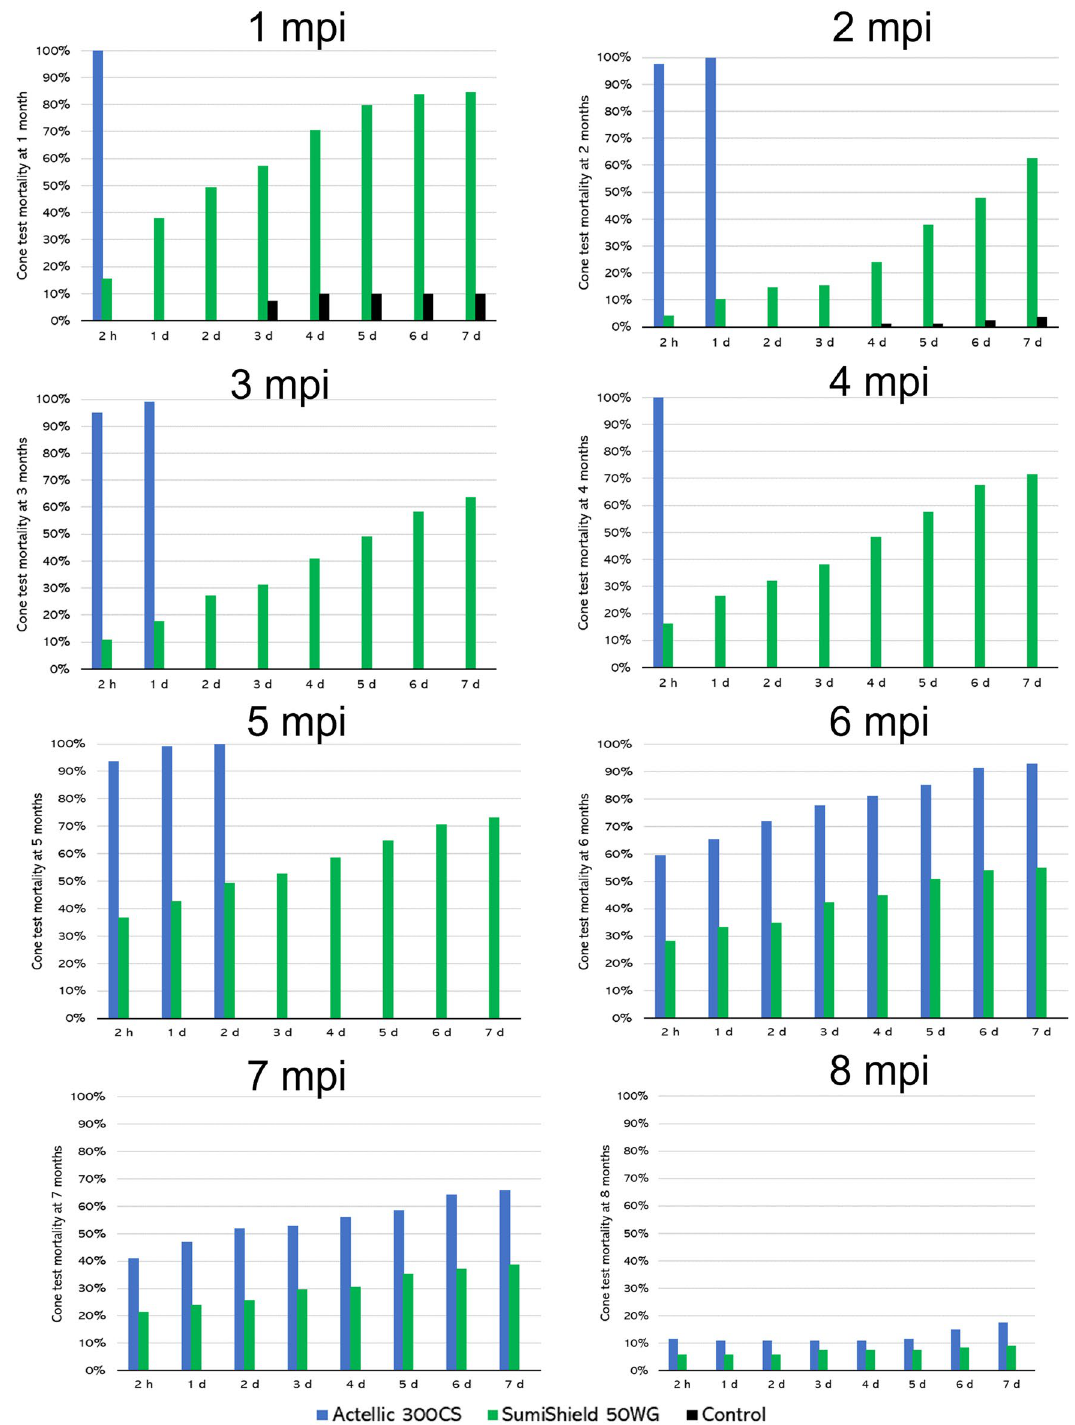
Figure 4. World Health Organization cone bioassays. Conducted up to 8 months post-intervention (mpi) using the Rockefeller Ae. aegypti strain. The graphs show acute (2 h after the 30-min exposure in the cones) and delayed (1 day to 7 days after the 30-min exposure in the cones) mortality values for each impact on free-flying mosquitoes (released in experimental houses). While delayed mortality in cones reached a maximum of 60% at 1 month post-spraying, delayed mortalities higher than 80% were maintained up to 7 months when mosquitoes were exposed in experimental houses 49 . This difference may be the product of the insecticide mode of action. Clothianidin targets the nicotinic acetylcholine receptor (nAChR) in the insect central nervous system 50 , leading to a delayed effect on the mortality of mosquitoes. As seen with other insecticide, chlorfenapyr 51 , clothianidin increases its efficacy when mosquitoes are free-flying.